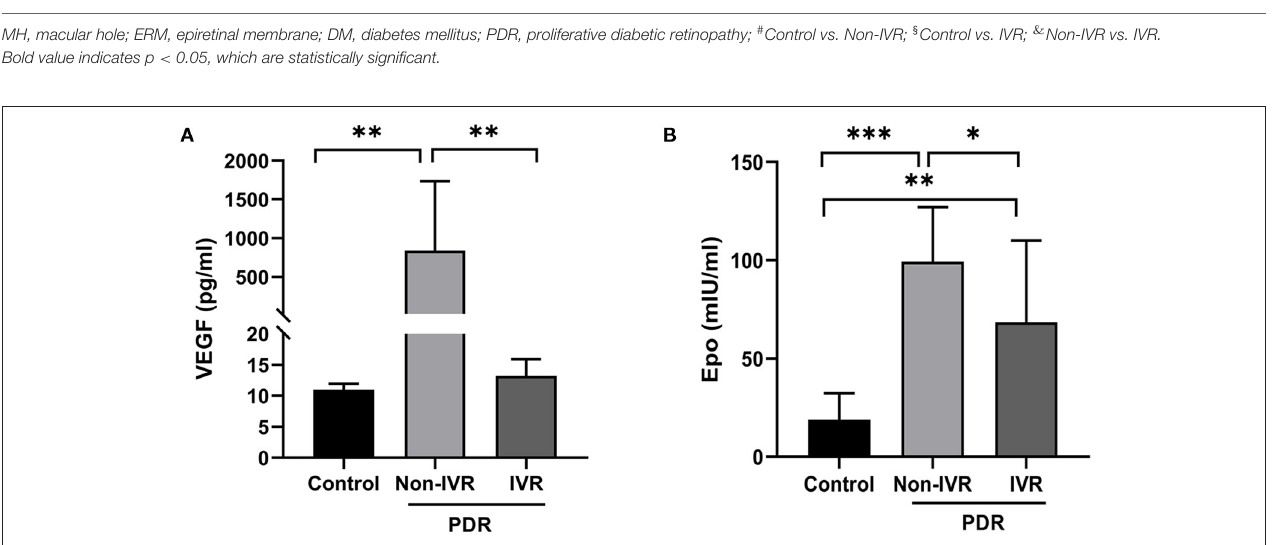
Frontiers in Medicine |